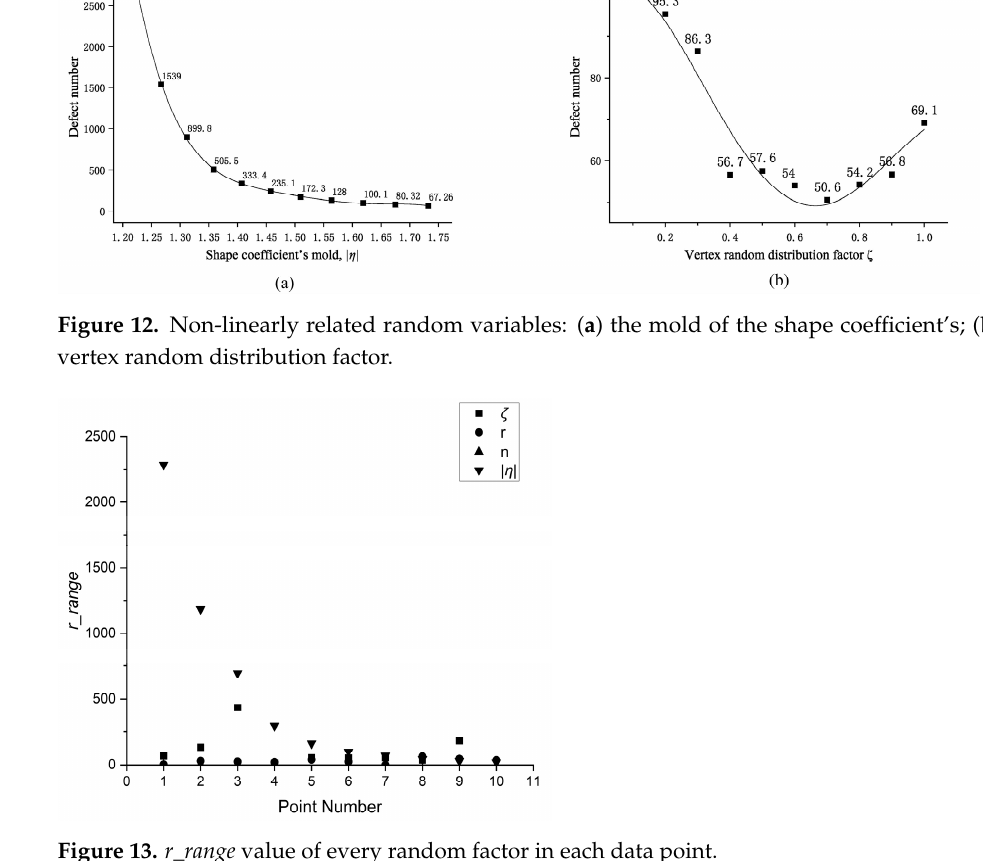
Figure 13. r_range value of every random factor in each data point.